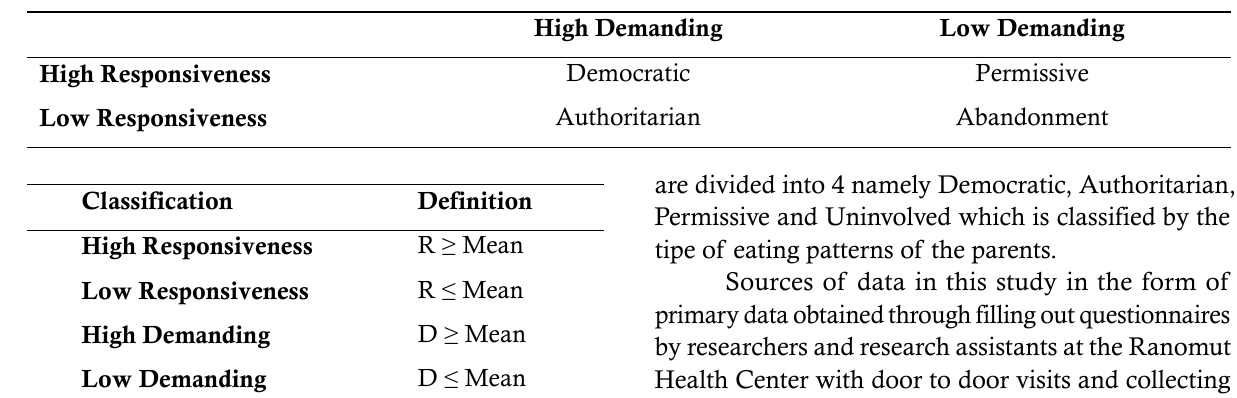
Eating Care Pattern Eating Care Table 3. Analysis of the relationship parental eating patterns and nutritional status of toddlers